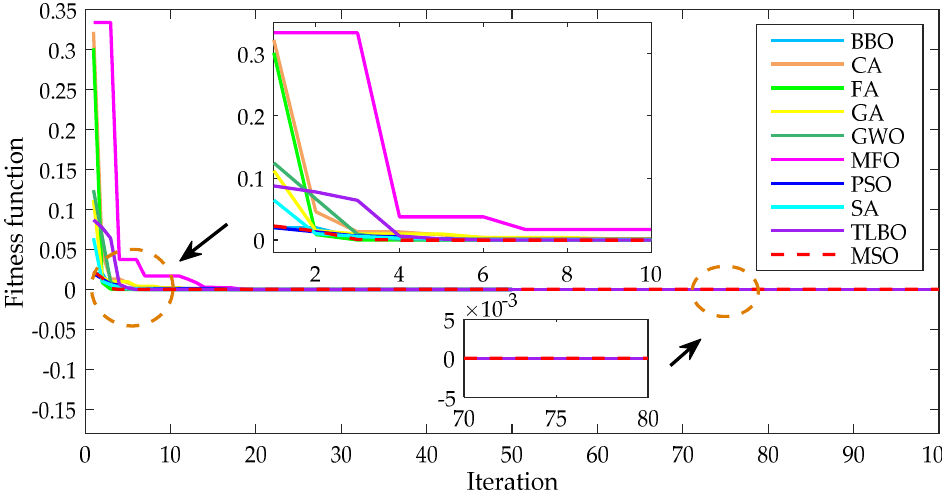
Figure 6. Comparison of convergence curves of ten algorithms in single peak test function.